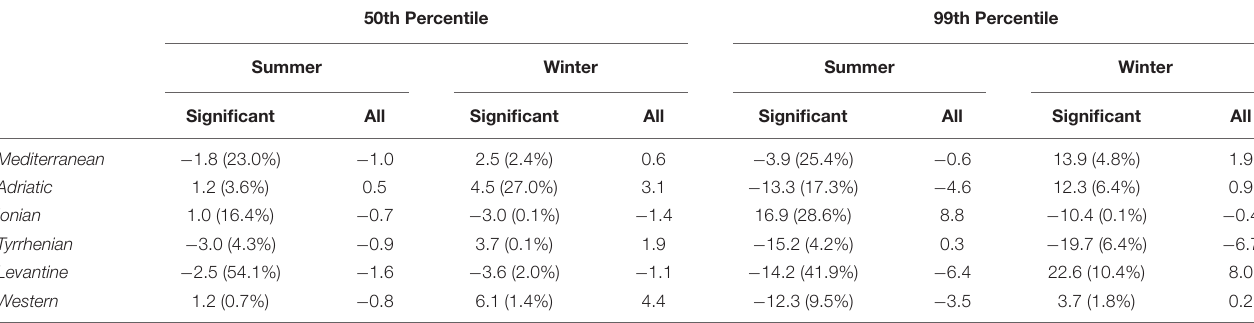
TABLE 2 | Spatial averages over the MS and sub-basins of the 50th and 99th percentile H max trends shown in Figure 11 (cm decade − 1 ), during 1981–2019 summer and winter seasons. 50th Percentile 99th Percentile Summer Winter Summer Winter Significant All Significant All Significant All Significant All